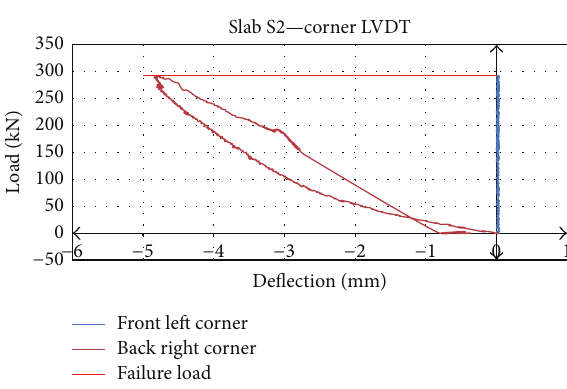
Figure 33: Slab S2—load V’s corner deflection.